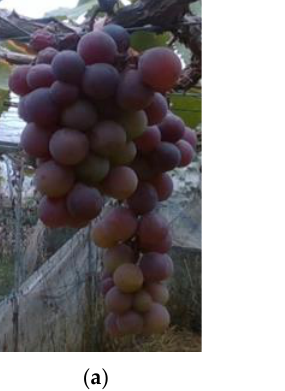
Figure 8. The input image and output image of DeepLabV3+. ( a ) The input image, and ( b ) the output image of the network.